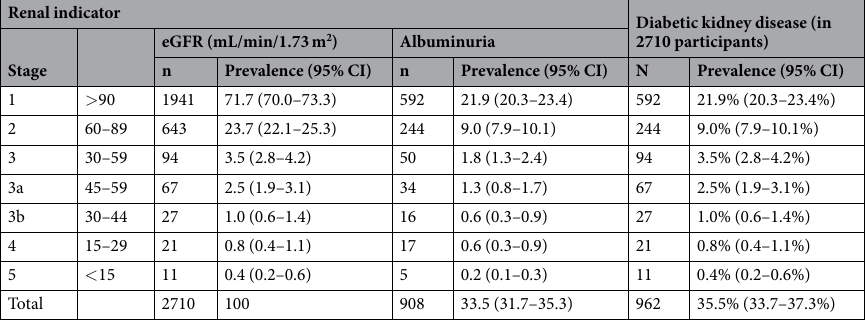
Table 4. Prevalence of indicators of renal damage in participants with diabetes, by disease stage. Note: Albuminuria was defined as urinary albumin to creatinine ratio > 30 mg/g creatinine. Diabetic kidney disease was defined as a combination of diabetes and an eGFR less than 60 mL/min/1.73 m 2 or presence of albuminuria. Abbreviations: eGFR, estimated glomerular filtration rate.